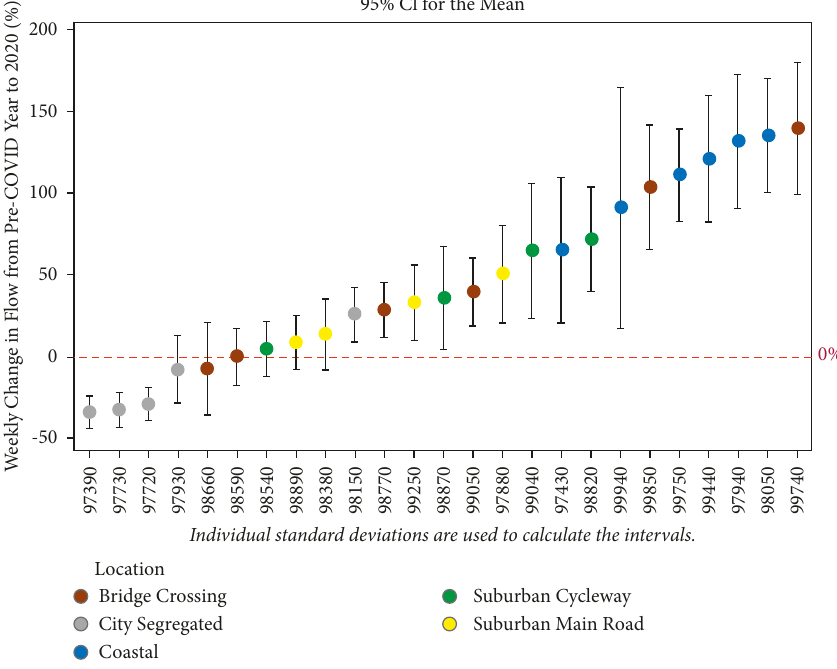
Figure 3: t -test change in average weekly flow pre/during COVID-19.